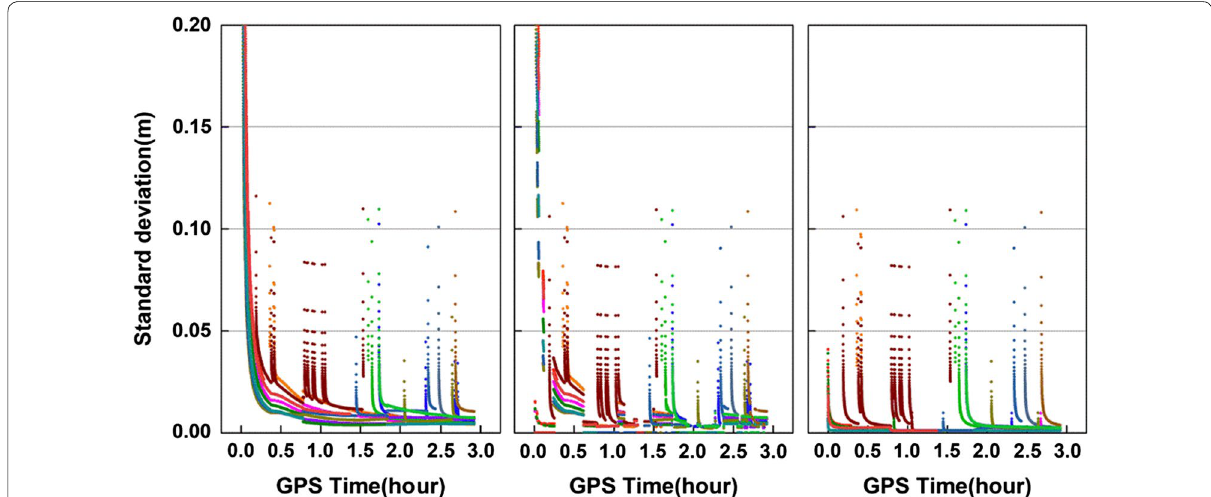
Fig. 8 The variety of DD ambiguity STD in the forward KF without AR (left), forward KF with AR (middle) and forward KF with integrated ambiguity constrained (right)